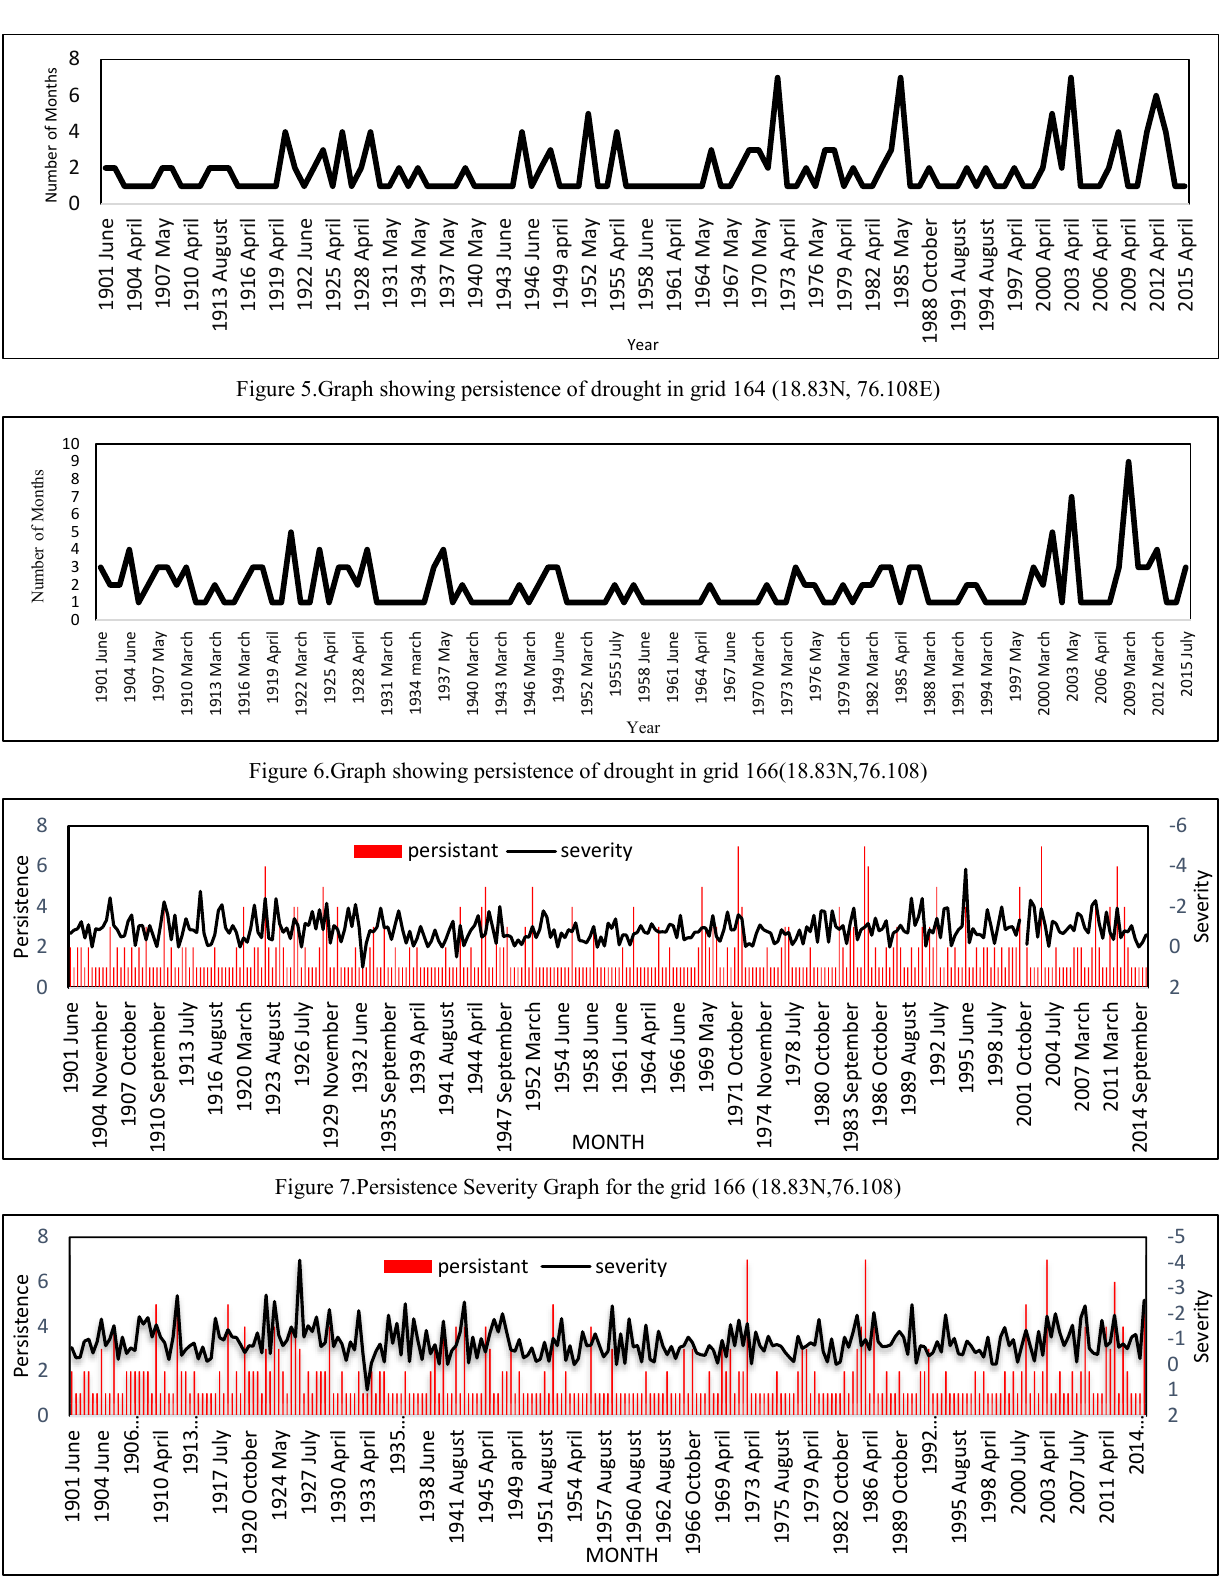
Figure 8.Persistence Severity Graph for the grid 164(18.83N,